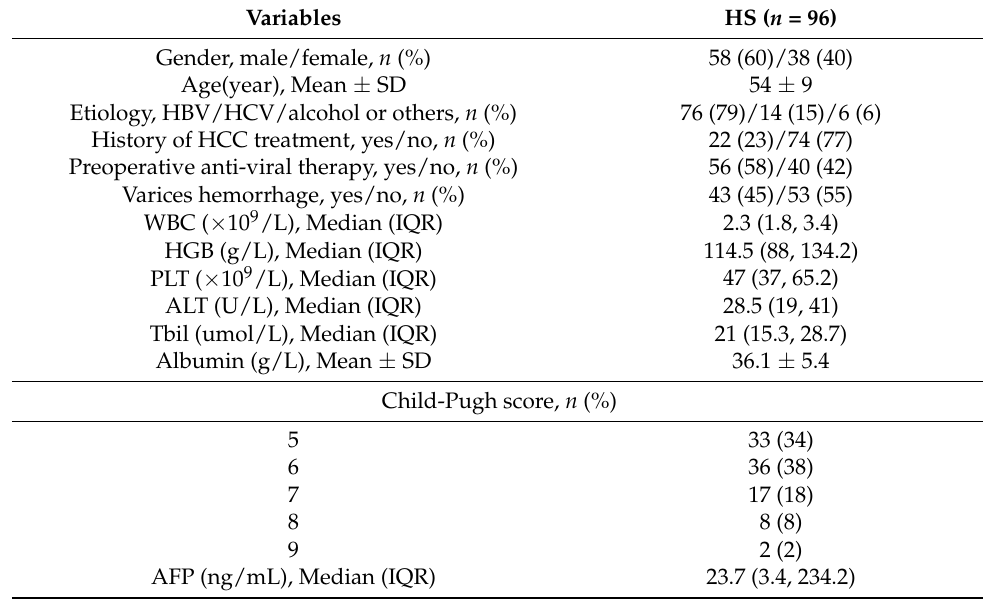
Table 1. Baseline characteristics of the HS group